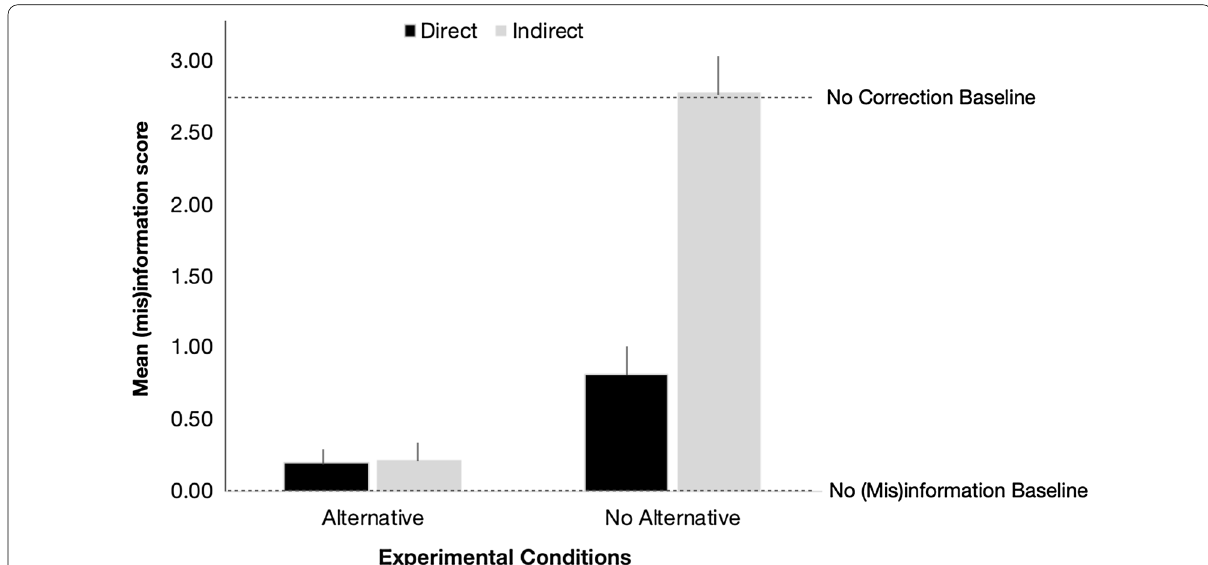
Fig. 3 Mean (mis)information score in Experiment 1A. Means for baseline participants are indexed with dotted lines. Error bars indicate standard error of the